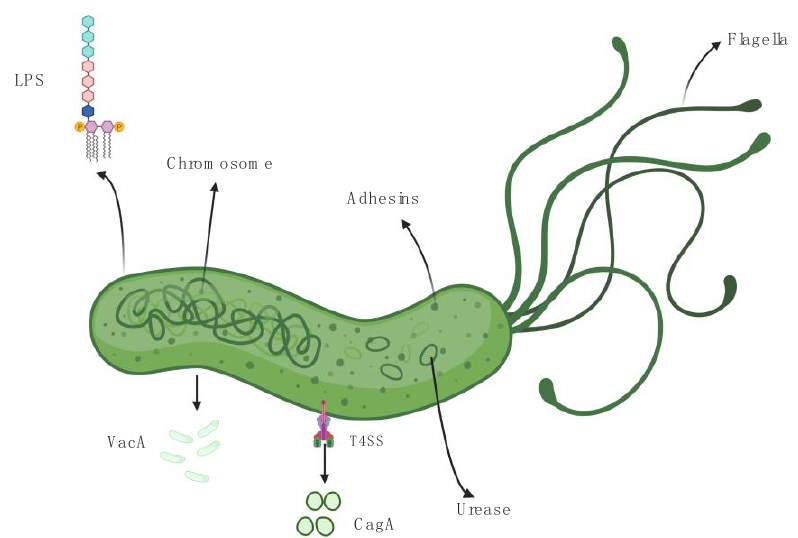
Figure 1. Insights of H. pylori structure and virulence factors. Created with BioRender.com (https://biorender.com/). H. pylori presents a unique helicoidal shape, which ensures effective colonization of the gastric mucosa. Flagella are essential for its mobility, whereas LPS is responsible for triggering host immune response. The urease, the main enzyme of the bacterium, is located inside the cytoplasm, where it maintains a constant alkaline pH, which facilitates efficient survival of the pathogen inside the gastric acid environment. VacA and CagA are two of H. pylori ’s main virulence factors. Once delivered to host cells, these two entities can mediate inflammatory pathways leading to